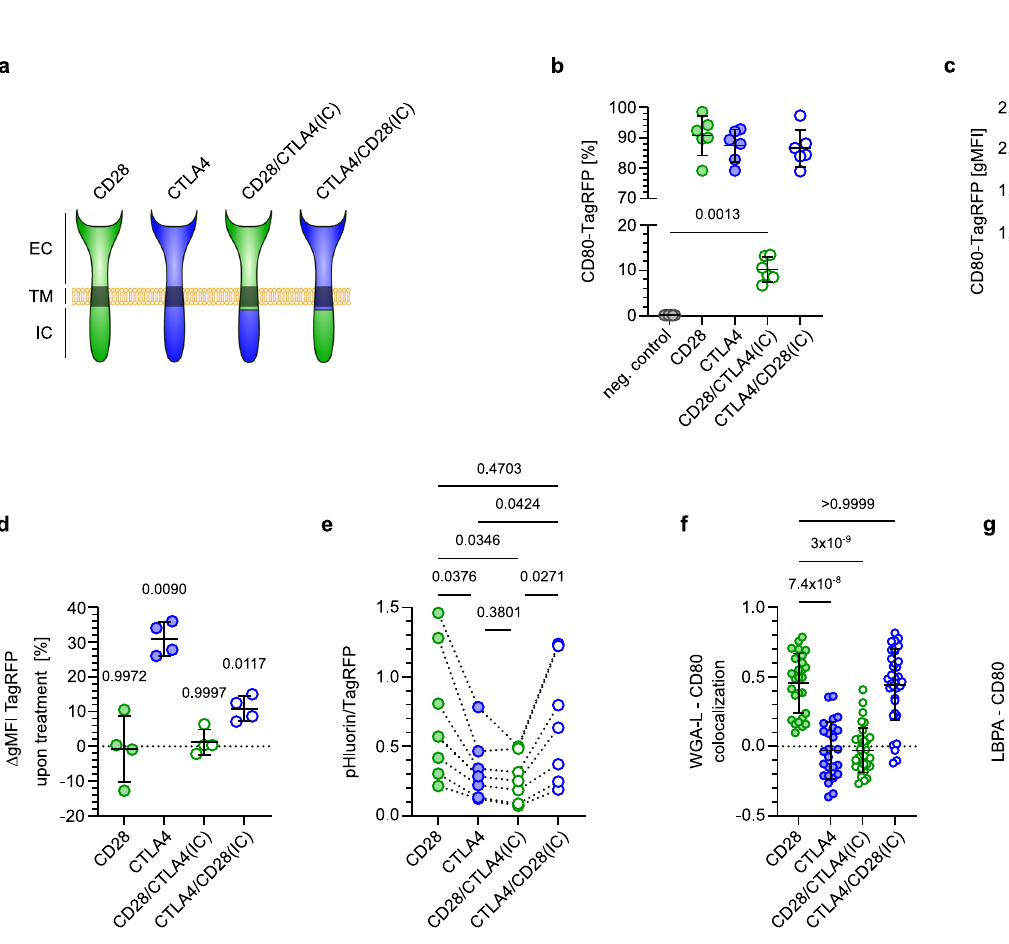
Fig. 5 | Extra- and intracellular domains of CD28 and CTLA4 modulate fate of trogocytosedCD80.a CompositionofCD28/CTLA4(IC)orCTLA4/CD28(IC)hybrid receptors compared to native CD28 and CTLA4. b – g 58 αβ A2 T cells expressing native or hybrid receptors co-cultured with CHO cells expressing CD80-TagRFP- pHluorin were analyzed by fl ow-cytometry ( b – e ) or confocal microscopy ( f , g ). Proportion of T cells acquiring CD80 ( b ) and amount of trogocytosed CD80 detectable per acquiring cell ( c ). Note that while only few T cells expressing the CD28/CTLA4(IC) hybrid receptor trogocytose CD80 (shown in b ), the amount per acquiring cell is comparable to T cells expressing native CTLA4 (shown in c ). d Increase in TagRFP signal intensity (gMFI) upon addition of Ba fi lomycin during trogocytosis of CD80-TagRFP. e pHluorin/TagRFP ratio of CD80-TagRFP-pHluorin trogocytosed via different receptors. Note that while receptors containing the CTLA4intracellulardomaintargettrogocytosedCD80tomoreacidiccompartments (shown in e ), blockade of lysosomal function only affects CD80 trogocytosed by receptorscontainingtheCTLA4extracellulardomain(shownin d ).Quanti fi cationof co-localization of trogocytosed CD80with wheat germ agglutinin lectin (WGA-L)( f )